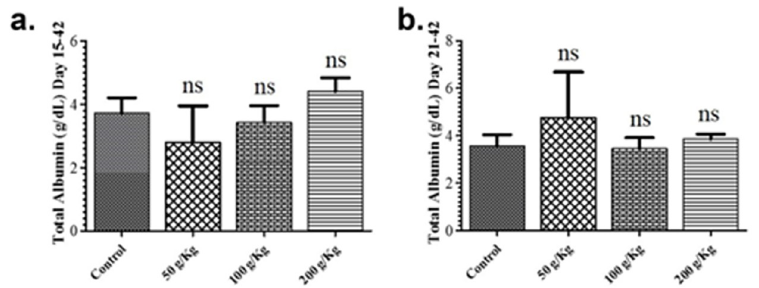
Fig 4. Graphs showing the comparison of total albumin of different quinoa enriched diet given chicken groups. The chickens were given 50 g/Kg, 100 g/Kg and 200 g/Kg of quinoa. ( a ). Total albumin levels of chicken fed from days 15 to 42 post-birth ( b ). Total albumin levels of chicken fed from days 21 to 42 post-birth. All data are expressed as means ± standard deviation (SD) from measurements on 15 chickens. � p � 0.05 in all quinoa supplemented diet fed groups versus the commercially available diet without quinoa fed control group. Note : ns means not significant.